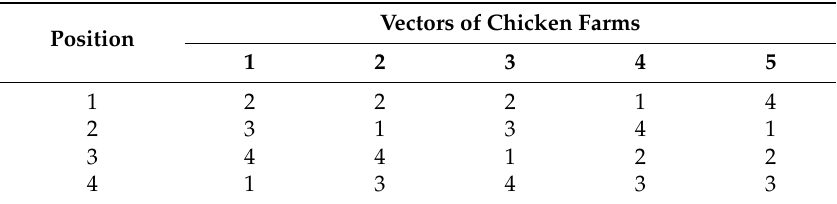
Table 5. Positions of initial vectors of chicken farms.